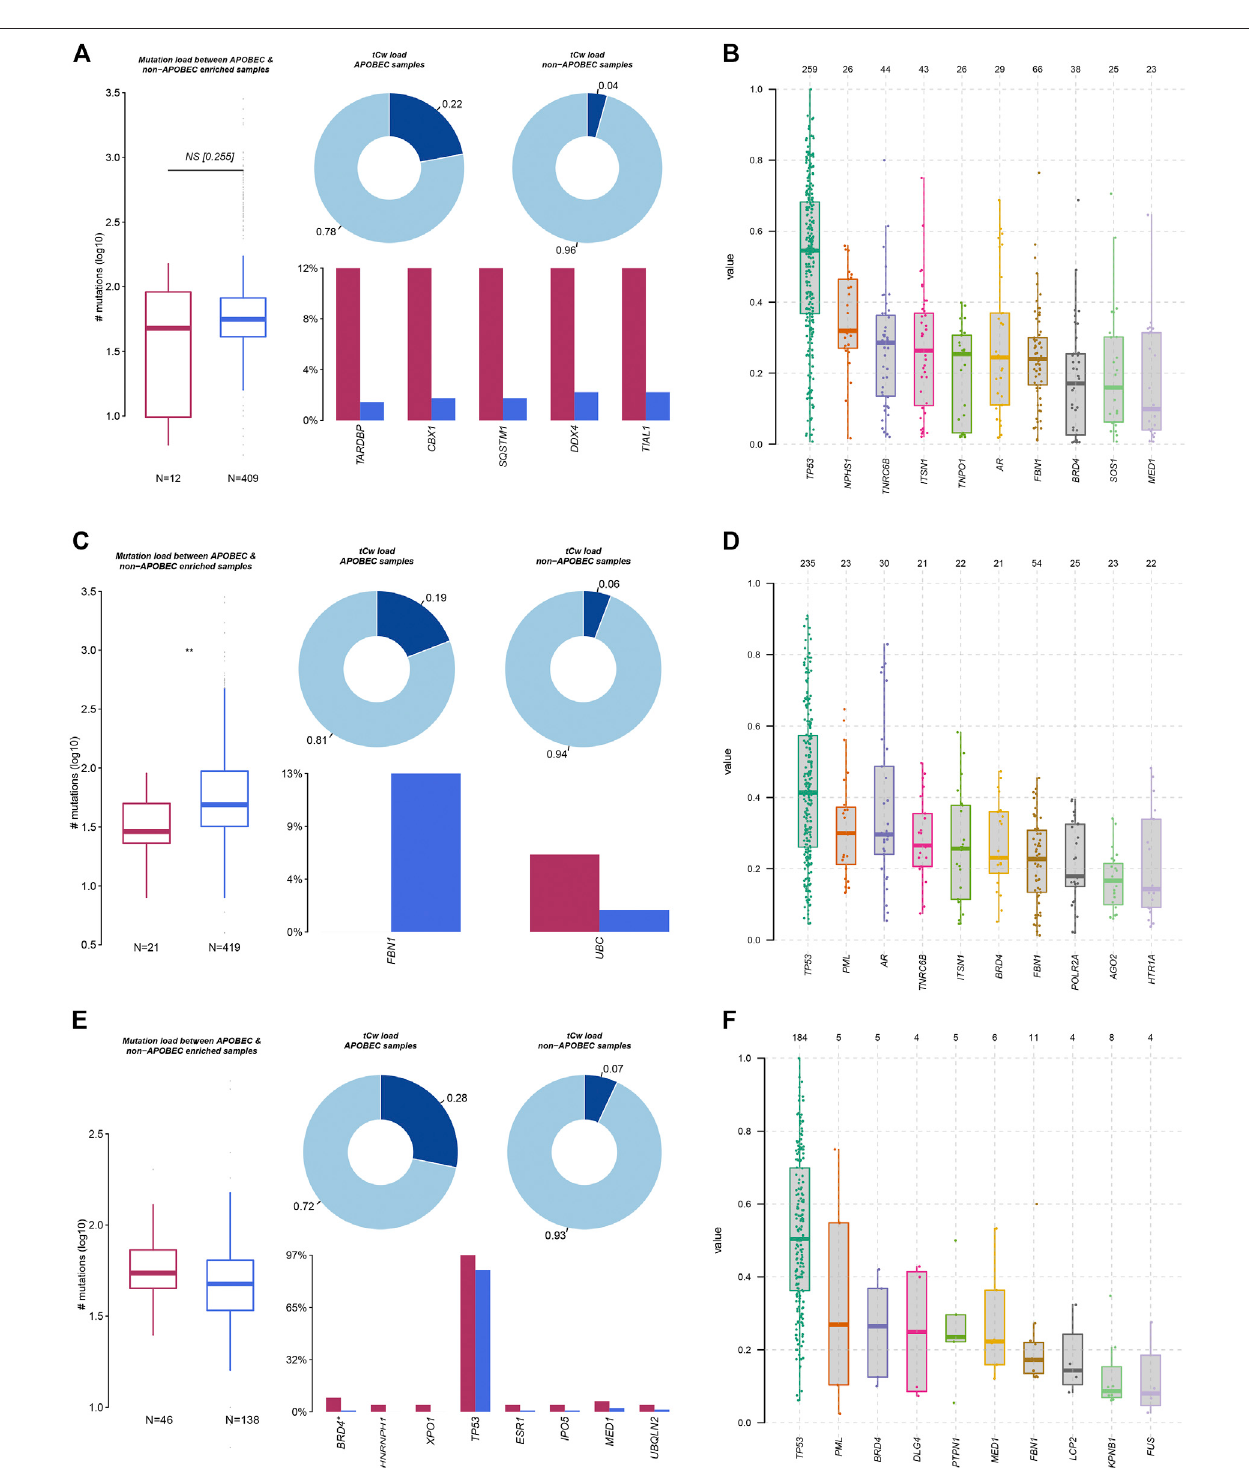
FIGURE 2 | Genetic alterations of LLPS regulators were related to the progression of digestive system neoplasms. (A,C,E) The APOBEC-signature mutation load of LLPS gene in COAD (A) , STAD (C) , and ESCA (E) . (B,D,F) The VAF analysis of LLPS gene in COAD (B) , STAD (D) , and ESCA (F) .